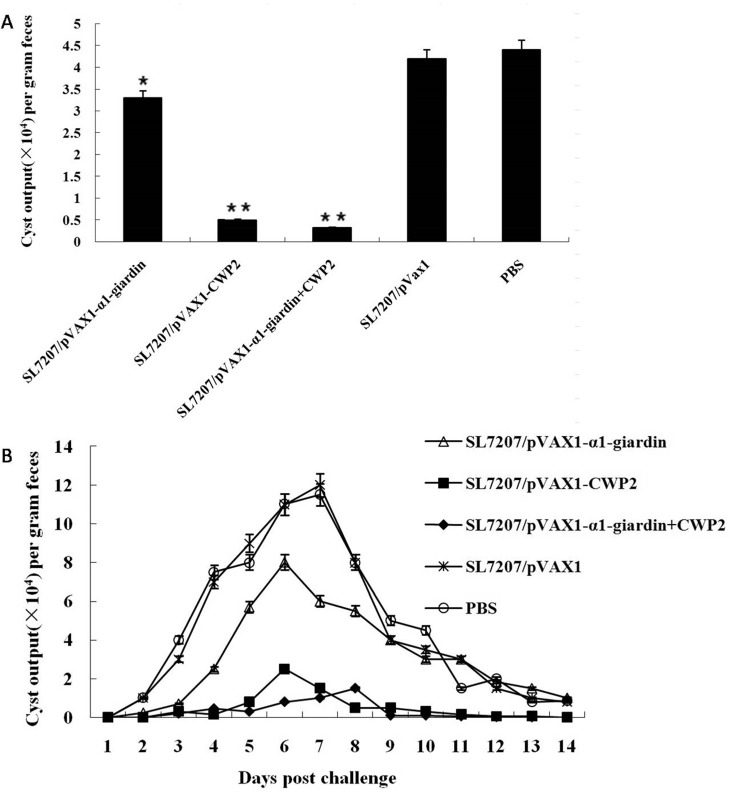
The average cyst output per gram feces of immunized mice over a 2-weeks period after infection.The average number of cysts per gram feces collected during the 2-weeks period was counted for each group (A) (*p<0.05,**p<0.01). Cyst release pattern over a 14-days period post challenge was count for each group (B). Values shown for each group are the mean ± SE (n = 10).